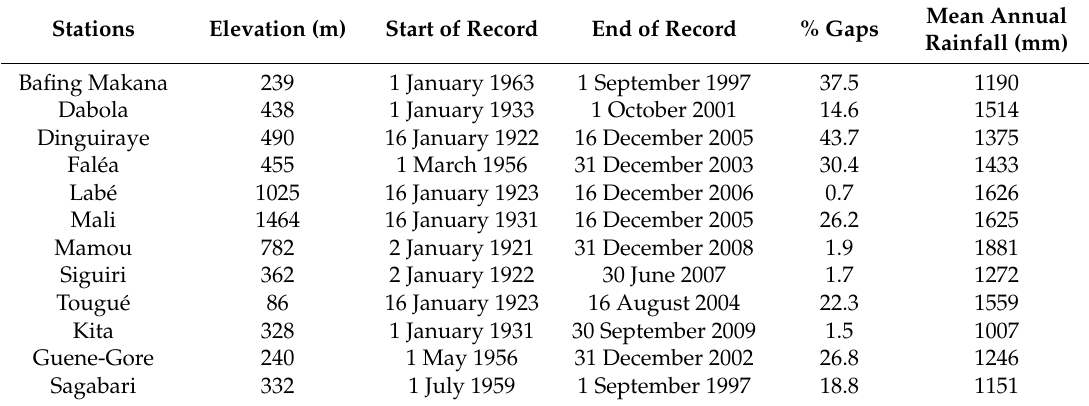
Table 1. List of the chosen rainfall stations: Mean annual rainfalls from observed values; % gap = percentage of days without measurement.